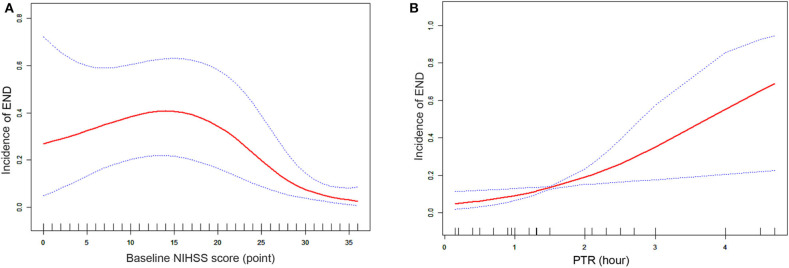
(A) Smooth curve fitting of 24-h END incidence and baseline NIHSS score (points). Red lines represent the spline plots of baseline NIHSS score and blue dotted lines represent the 95% CIs of the spline plots. Adjusted factors: mode of stroke onset and PTR. (B) Smooth curve fitting of 24-h END incidence and PTR (per hour). Red lines represent the spline plots of PTR and blue dotted lines represent the 95% CIs of the spline plots. Adjusted factors: mode of stroke onset and baseline NIHSS score.